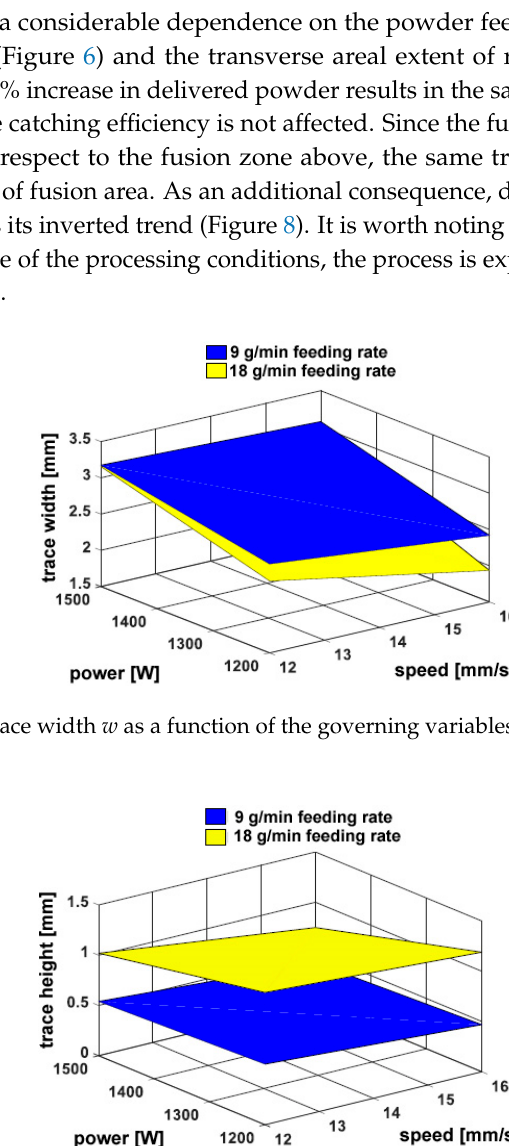
Figure 6. Trace height h as a function of the governing variables; flat deposition.